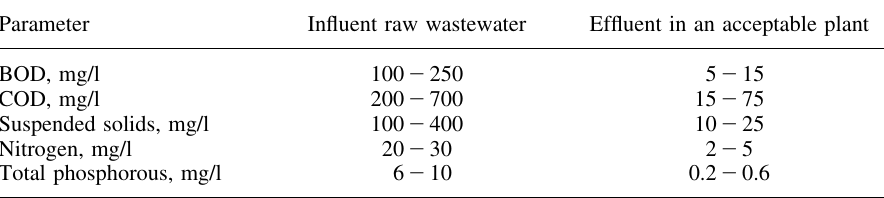
Table 1. Typical composition of domestic waste water, with indication of effluent standards. From Bailey & Ollis (1986). Parameter Influent raw